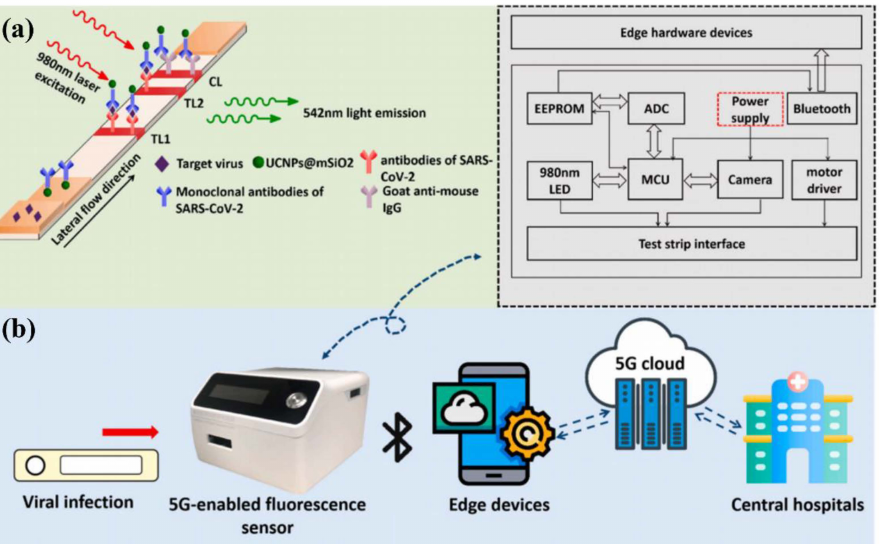
Figure 3. ( a ) The working principle of the detection of S and N proteins from SARS-CoV-2 based on NaYF 4 : Yb, Er@SiO 2 nanoparticles; ( b ) 5G-enabled NIR-fluorescence sensor used for SARS-CoV-2 diagnosis. Reprinted with permission from ref. [47]. Copyright 2021,